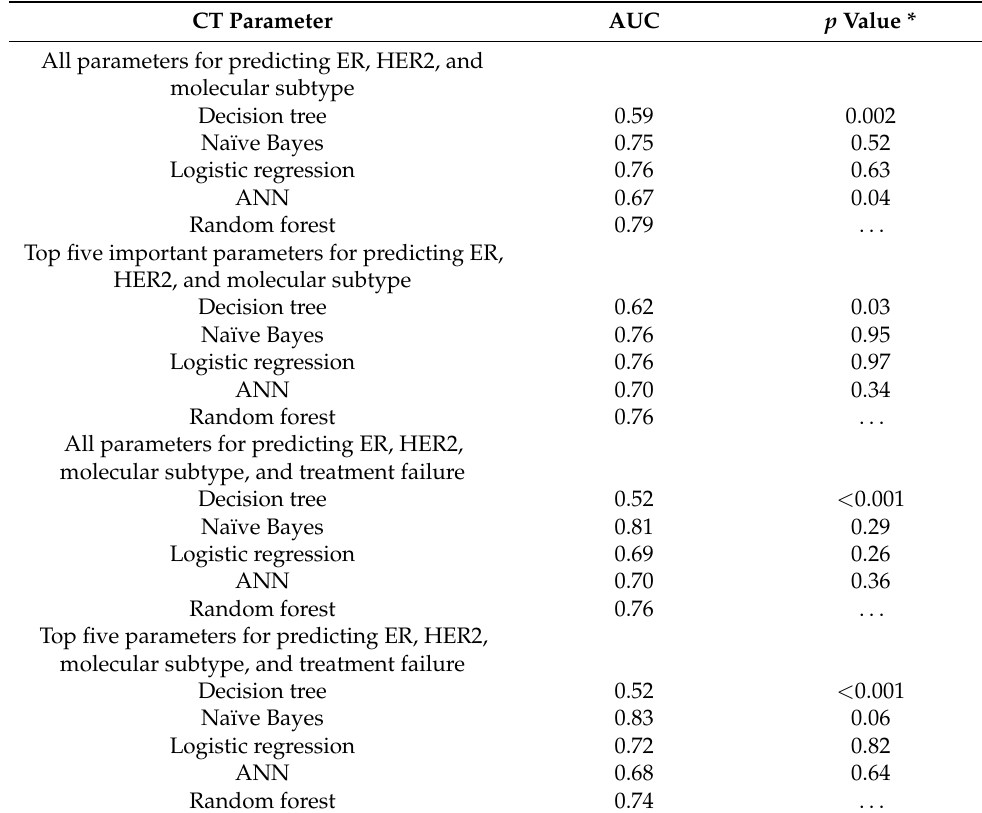
Table 8. Comparison of AUCs according to number of CT parameters of integrated machine learning models to predict histological factors and treatment